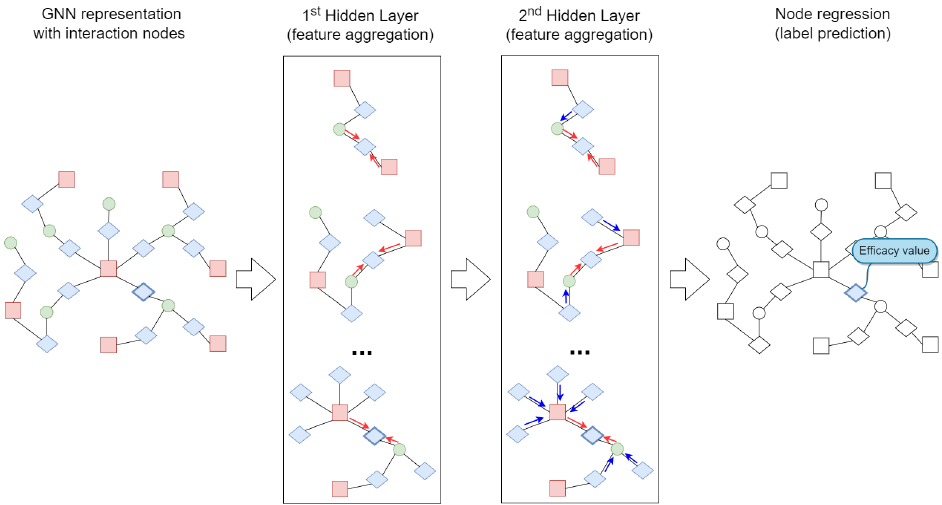
Figure 4. Architecture for siRNA efficacy value prediction. Each HinSAGE hidden layer performs a node feature aggregation among neighbours. For each query node, such as the bold shape inter- action node, red arrows aggregate neighbours’ features, and blue arrows aggregate the neighbour neighbours’